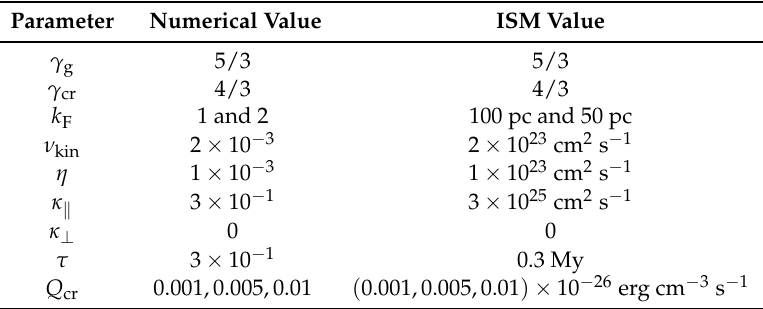
Table 1. Non-dimensional parameters used to solve the magnetohydrodynamic (MHD) and cosmic ray fluid equations and their corresponding ISM